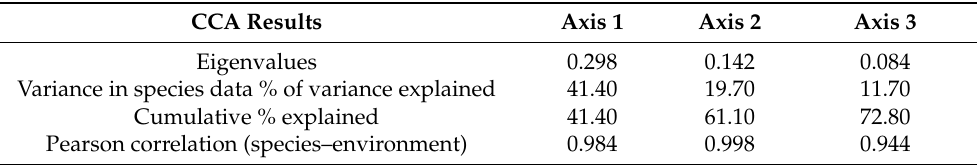
Figure 7. Annual means of relative humidity (RH), air temperature (Temp), and relative light intensity (RLI) in nine stands along the forest remnants to plantation stands of three exotic plantations. EC: Eucalyptus camaldulensis , AA: Acacia auriculiformis , AM: A. mangium . Different superscript letters of each parameter indicate significant difference at p < 0.05. Table 4. Results of the canonical correspondence analysis (CCA) of the relationship between tree species and the environmental